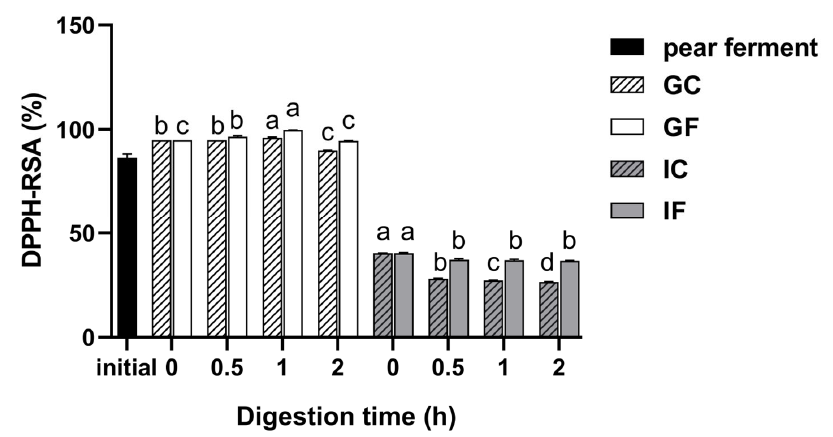
Figure 5. Changes of DPPH-RSA of ‘Xuehua’ pear ferment during the simulated gastric and intestinal digestion in vitro. Different letters indicate significant differences in the same group under different digestion times ( p < 0.05). Data shown as means ± SD of three replicates ( n = 3).